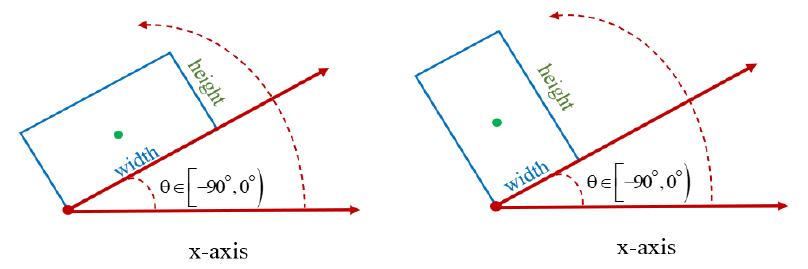
Figure 5. Annotation information of the dataset.